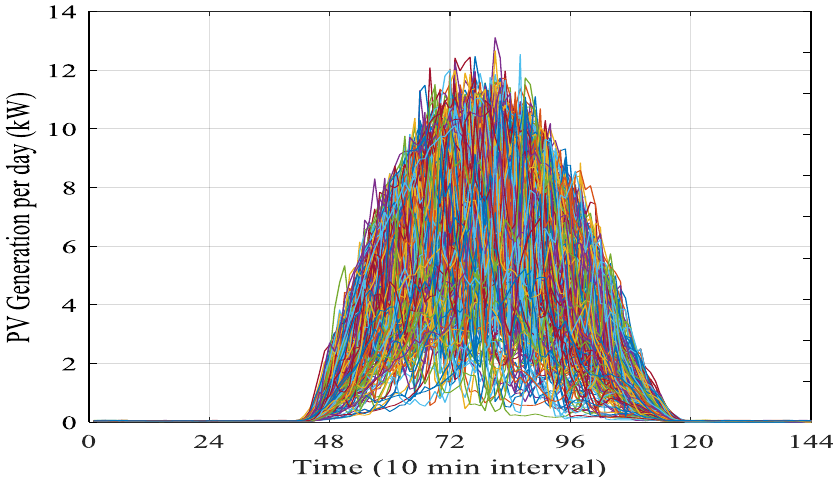
Figure 4. PV generation profiles for five different solar variability types.